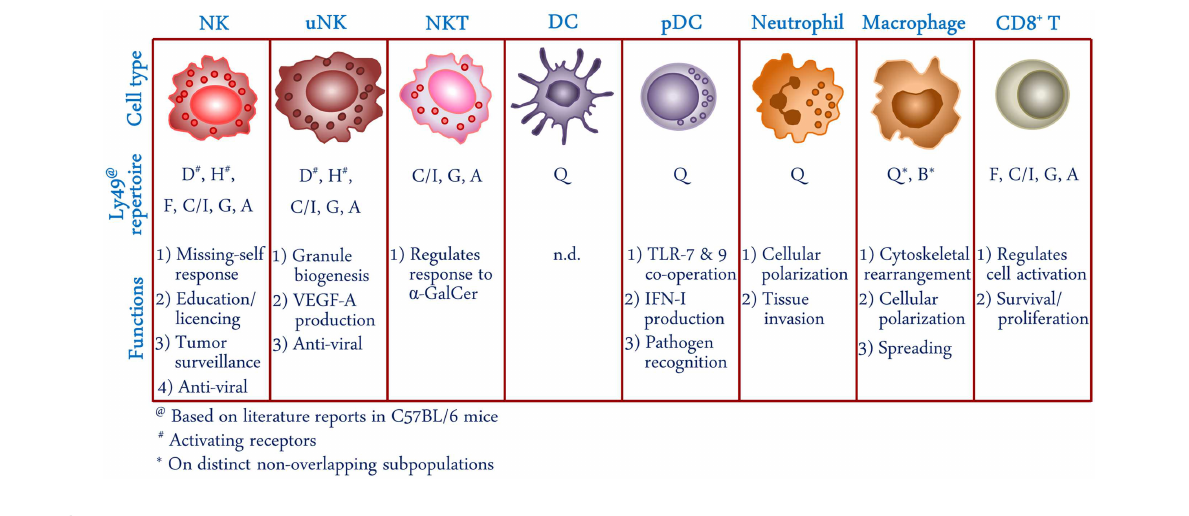
natural killerT; DC, dendritic cells; pDC, plasmacytoid dendritic cell; α -GalCer, α -galactosylceramide;VEGF-A, vascular endothelial growth factor A;TLR,Toll-like receptor; IFN-I, type I interferon; n.d., not